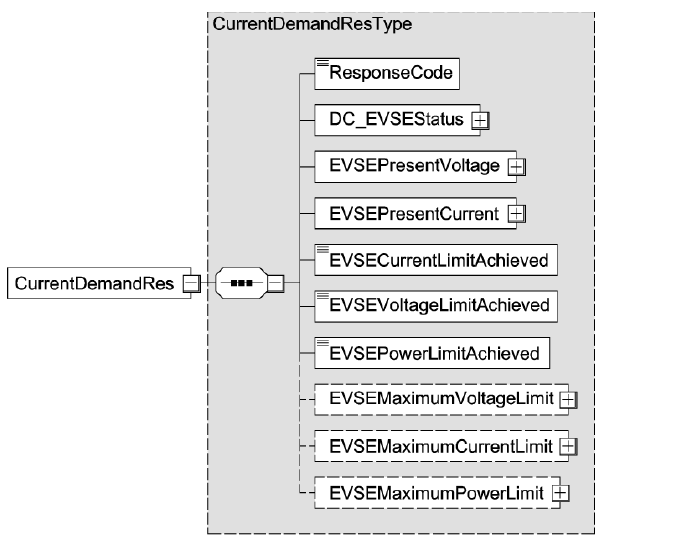
Figure 3. Schema Diagram of the